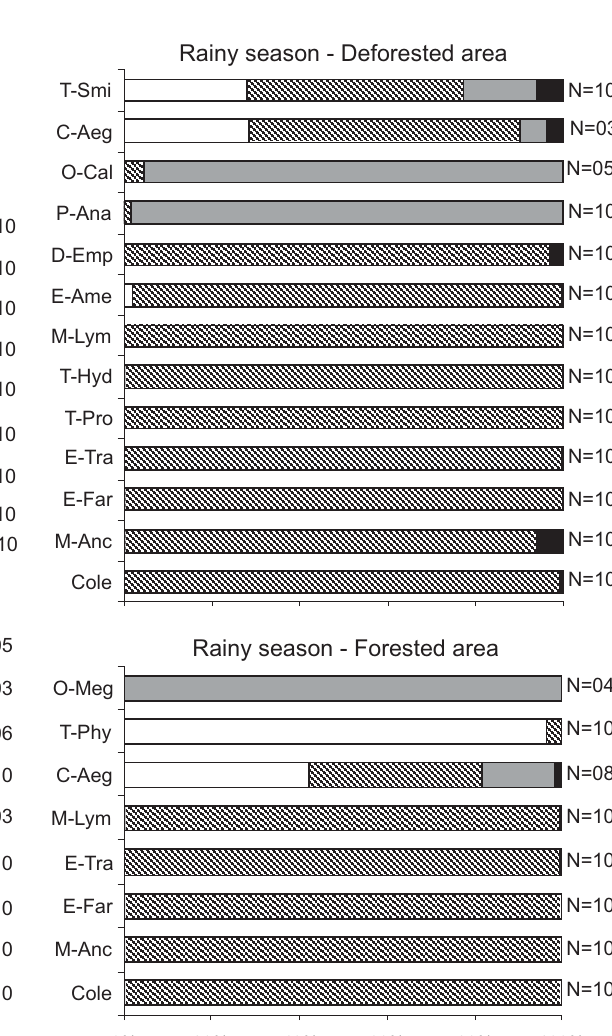
Page 700, replace : Figure 4 with : Figure 4 below.